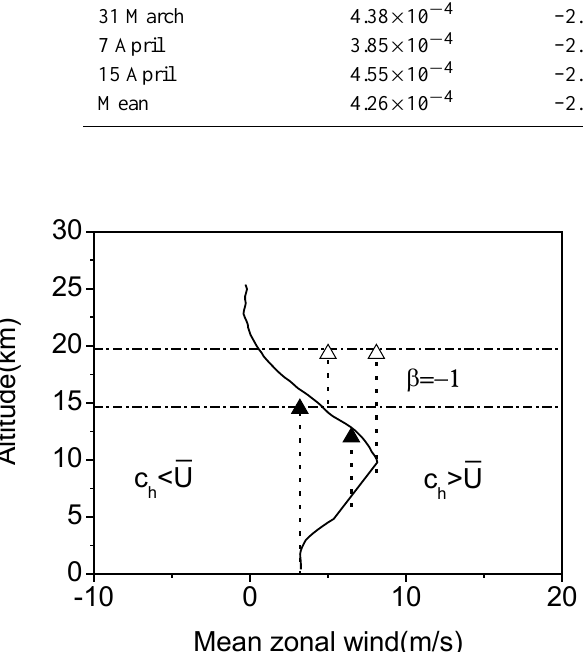
Fig. 4. Mean zonal wind profile observed during March and April 2003 over the Beijing Meteorological Observatory (solid line). Up- ward pointing triangles represent upward propagating waves. The open triangles represent waves for which c h >U , whereas the solid triangles represent c h <U